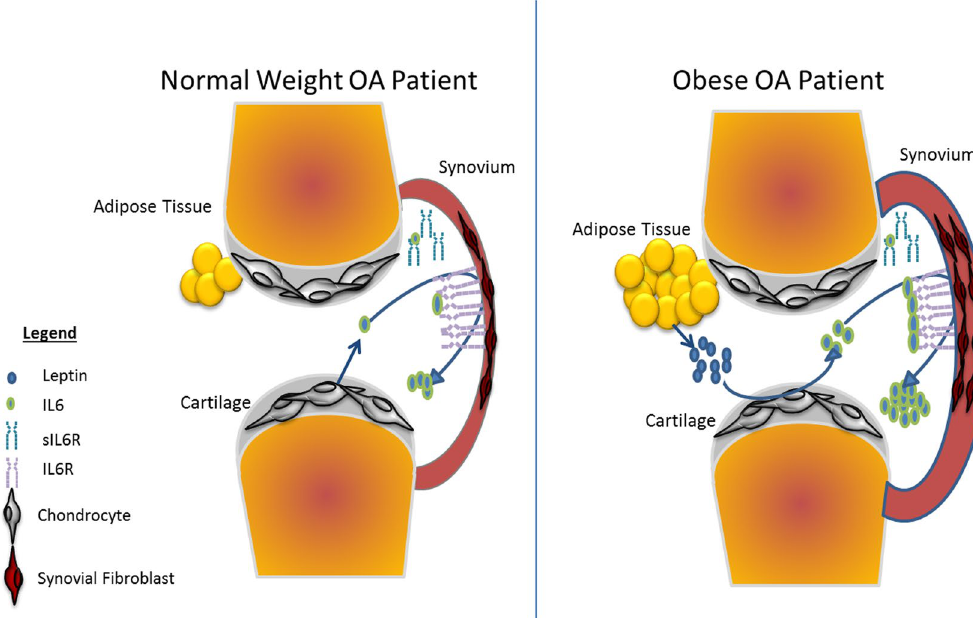
Figure 6. Predicted mechanism of IL-6 signalling via chondrocyte/synovial fibroblast cellular cross talk and its exacerbation in obese patients with OA. ( A ) In normal-weight OA patients, the chondrocytes in the articular cartilage secrete IL-6 into the synovial fluid. Chondrocyte secreted IL-6 binds to IL-6R on the surface of synovial fibroblasts and promotes IL-6 secretion from synovial fibroblasts. ( B ) In obese patients with OA, pathological levels of leptin stimulate greater secretion of IL-6 from the chondrocytes in the articular cartilage. This greater secretion of IL-6 promotes greater cellular cross-talk with synovial fibroblasts, leading to greater IL-6 secretion into the synovial